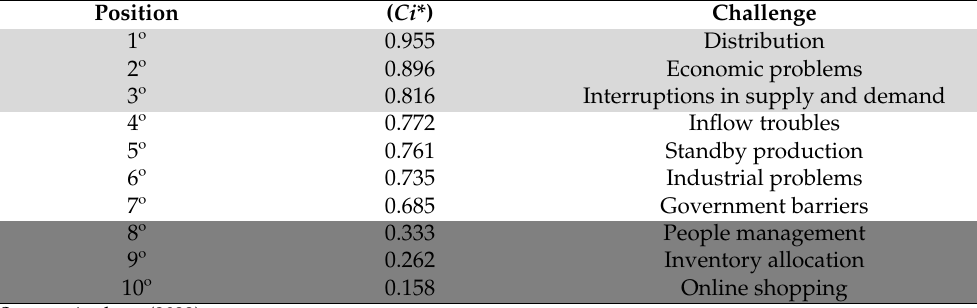
Table 8. Ranking of